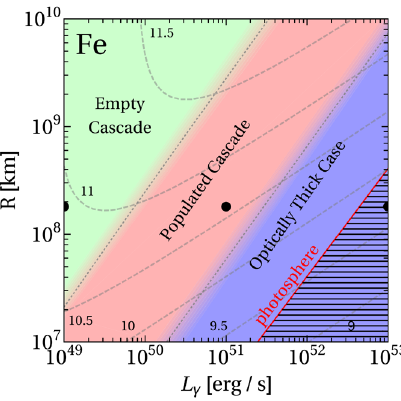
Figure 1. Isotope chart depicting the development of the nuclear cascade in the source for di ff erent luminosities and pure 56 Fe in- jection. The color code indicates the energy per isotope relative to the total isotropic equivalent energy. Note that the size of the region is kept constant. Figure taken from [6]. Figure 2. Parameter space scan in gamma-ray luminosiy L γ and size of the region R showing the three di ff erent regimes (see main text for details) of the nuclear cascade (pure 56 Fe injected). The transitions between the regimes are indicated by the gray dot- ted lines. Sub-photospheric emission is obtained for parameters Figure 3. Cross section data (top) and disintegration rates in the in the hatched region. The primary maximum energy in the ob- radiation field of a GRB (bottom left) as well as in the CMB server’s frame (in GeV) is superimposed by the gray contours (bottom right) for the double-magic nucleus 40 Ca. The GRB and the black dots represent the parameters for the nuclear cas- spectrum is described by a broken power law with spectral in- cade shown in Fig. 1 ( L γ = 10 51 erg s − 1 not shown). Note that dex α = 1 . 0 below and β = 2 . 0 above the break at 1 keV (SRF), the Lorentz factor is fixed to Γ 300. Figure taken from [6]. while the obtained CMB rate assumes a thermal target photon ∼ field with T = 2 . 73 K. Figure taken from